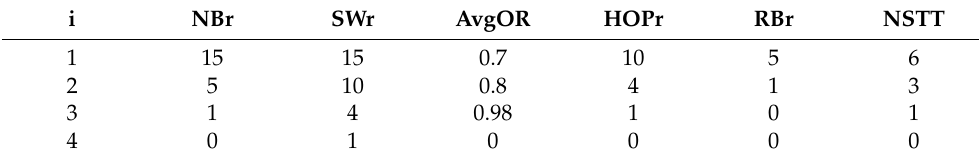
Table 3. Application example of the imbrical spreading function where (NB,